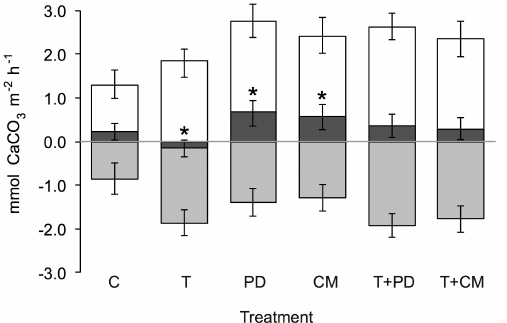
Figure 7. Mean sediment net calcification ( G net : mmolCaCO 3 m − 2 h − 1 ) in response to warming ( + 2.4 ◦ C) and each OM treatment (phytodetritus and coral mucus). Control ( C ; n = 9) and warming ( T ; n = 7) treatments are averaged over all four incubations and the replicate chambers therein, while phytodetritus (PD), coral mucus (CM), and combination ( T + PD, T + CM) treatments are averaged over the two incubations (and replicate chambers therein) in which each respective OM treatment was used ( n = 4). Average measured rates ± SD are represented in white for light G net (positive) and grey for dark G net (negative). Black bars represent the 24h diel G net averaged from light and dark measurements, and the * next to these bars indicates if the value is significantly different from the control.